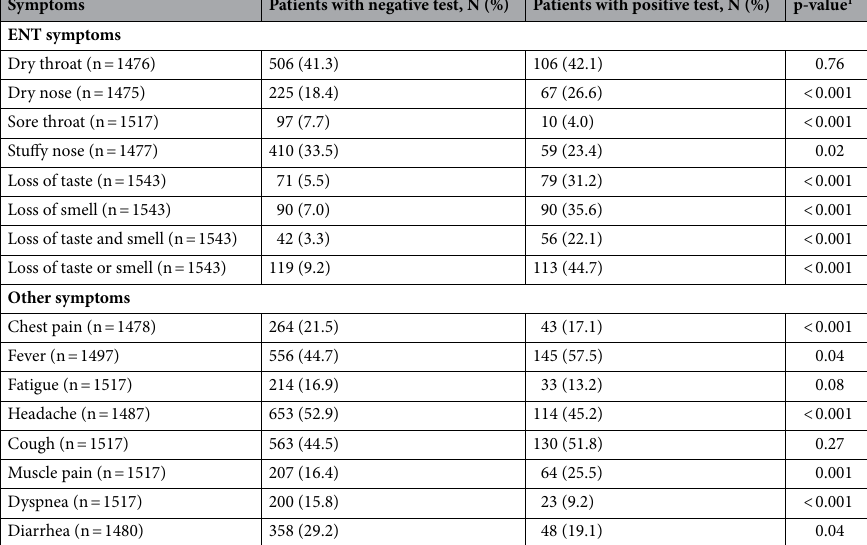
Table 2. Proportion of symptoms reported by patients with negative and positive SARS-CoV-2 RT-PCR test (N = 1543). 1 Univariate logistic regression (adjusted for clustering within